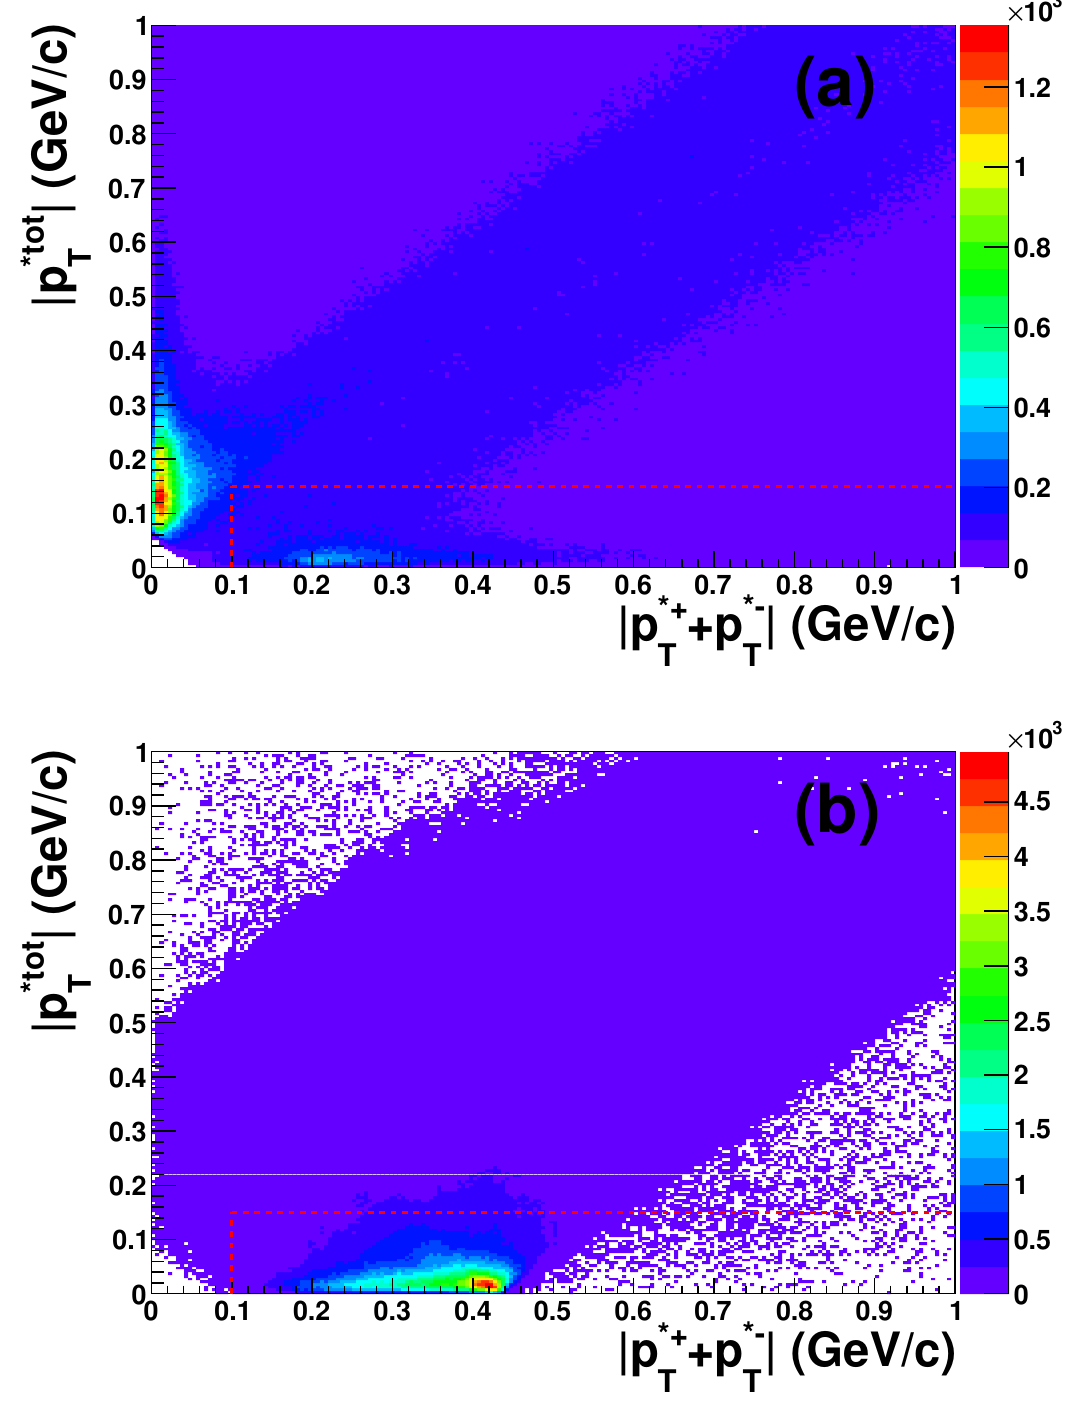
Figure 1 . Scatter plots of | p ∗ tot | versus | p ∗ + + p ∗− | after the event selection except for the selections T T T using | p ∗ + + p ∗− | and | p ∗ tot | : (a) for the data sample and (b) for the signal MC. Dotted red lines T T T show the selected region according to the selections using | p ∗ + + p ∗− | and | p ∗ tot | T T T